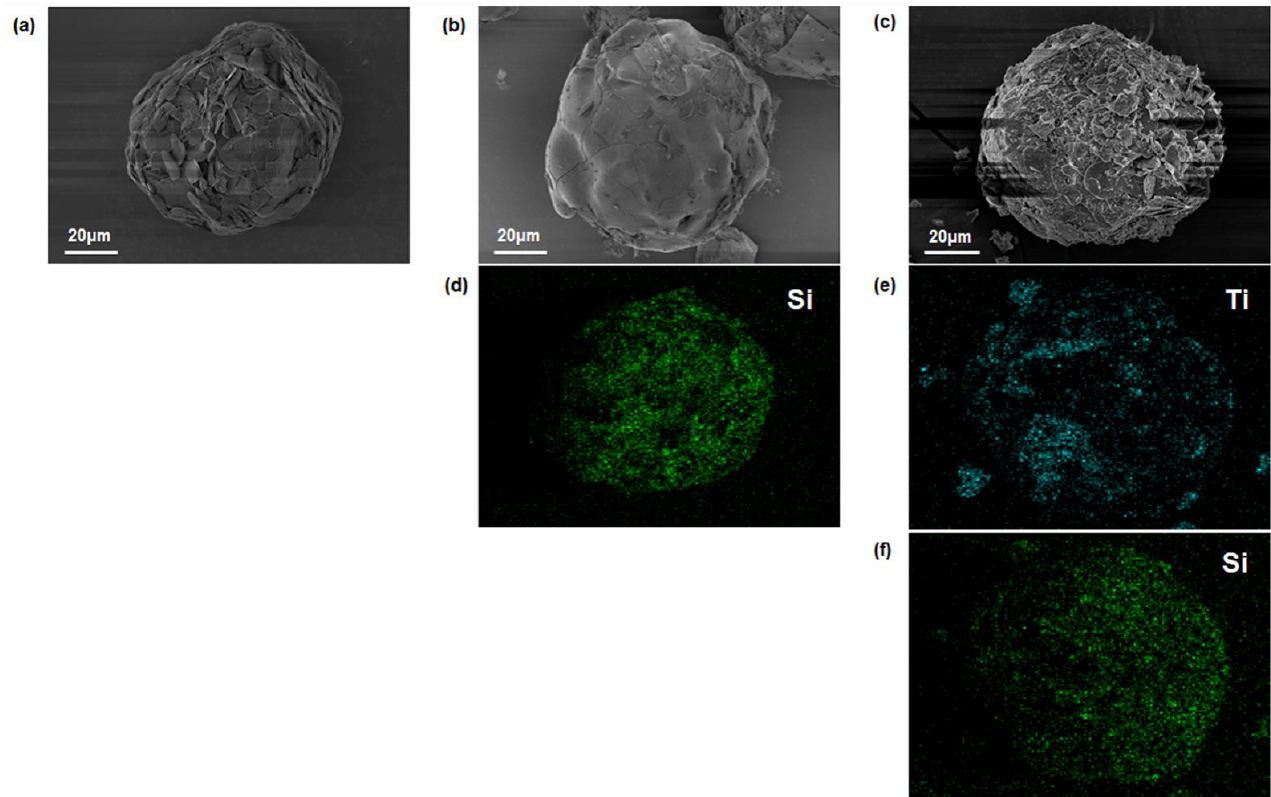
Figure 3. SEM image of surface modified ABN: ( a ) raw ABN, ( b ) polysilazane-coated ABN (PSZ-ABN), ( c ) MXene-PSZ-ABN. SEM-EDS mapping showing the distribution of ( d ) Si of PSZ-ABN, ( e ) Ti and ( f ) Si of MXene-PSZ-ABN.